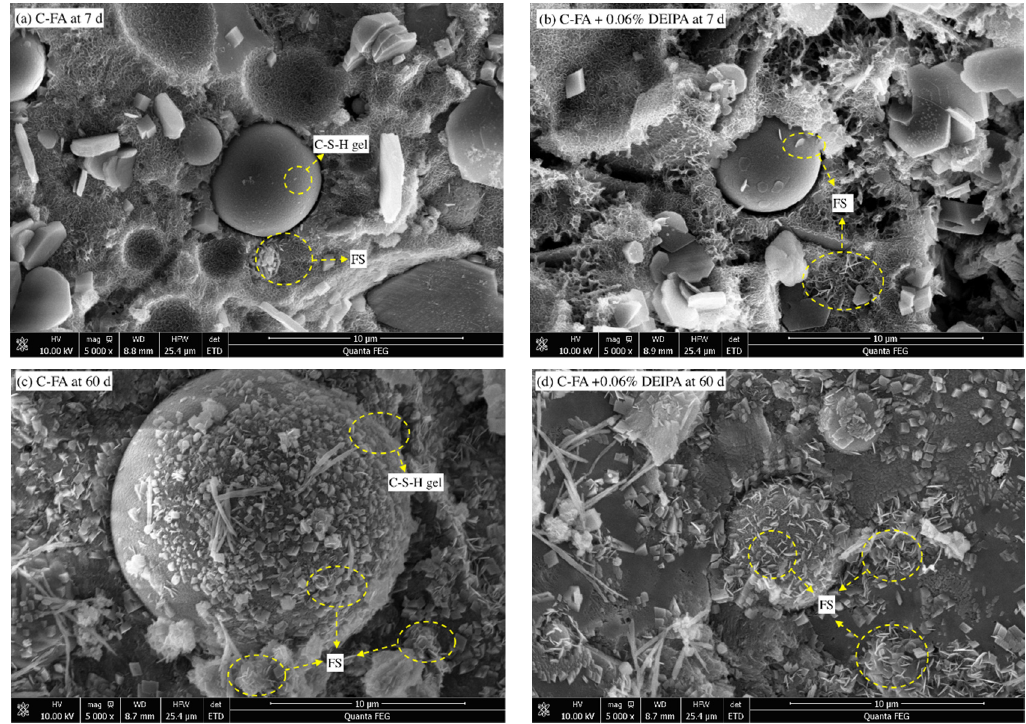
Figure 8. SEM images of C-FA, ( a ) C-FA at 7 d, ( b ) C-FA with 0.06% DEIPAat 7 d, ( c ) C-FA at 60 d, ( d ) C-FA with 0.06% DEIPA at 60 d.